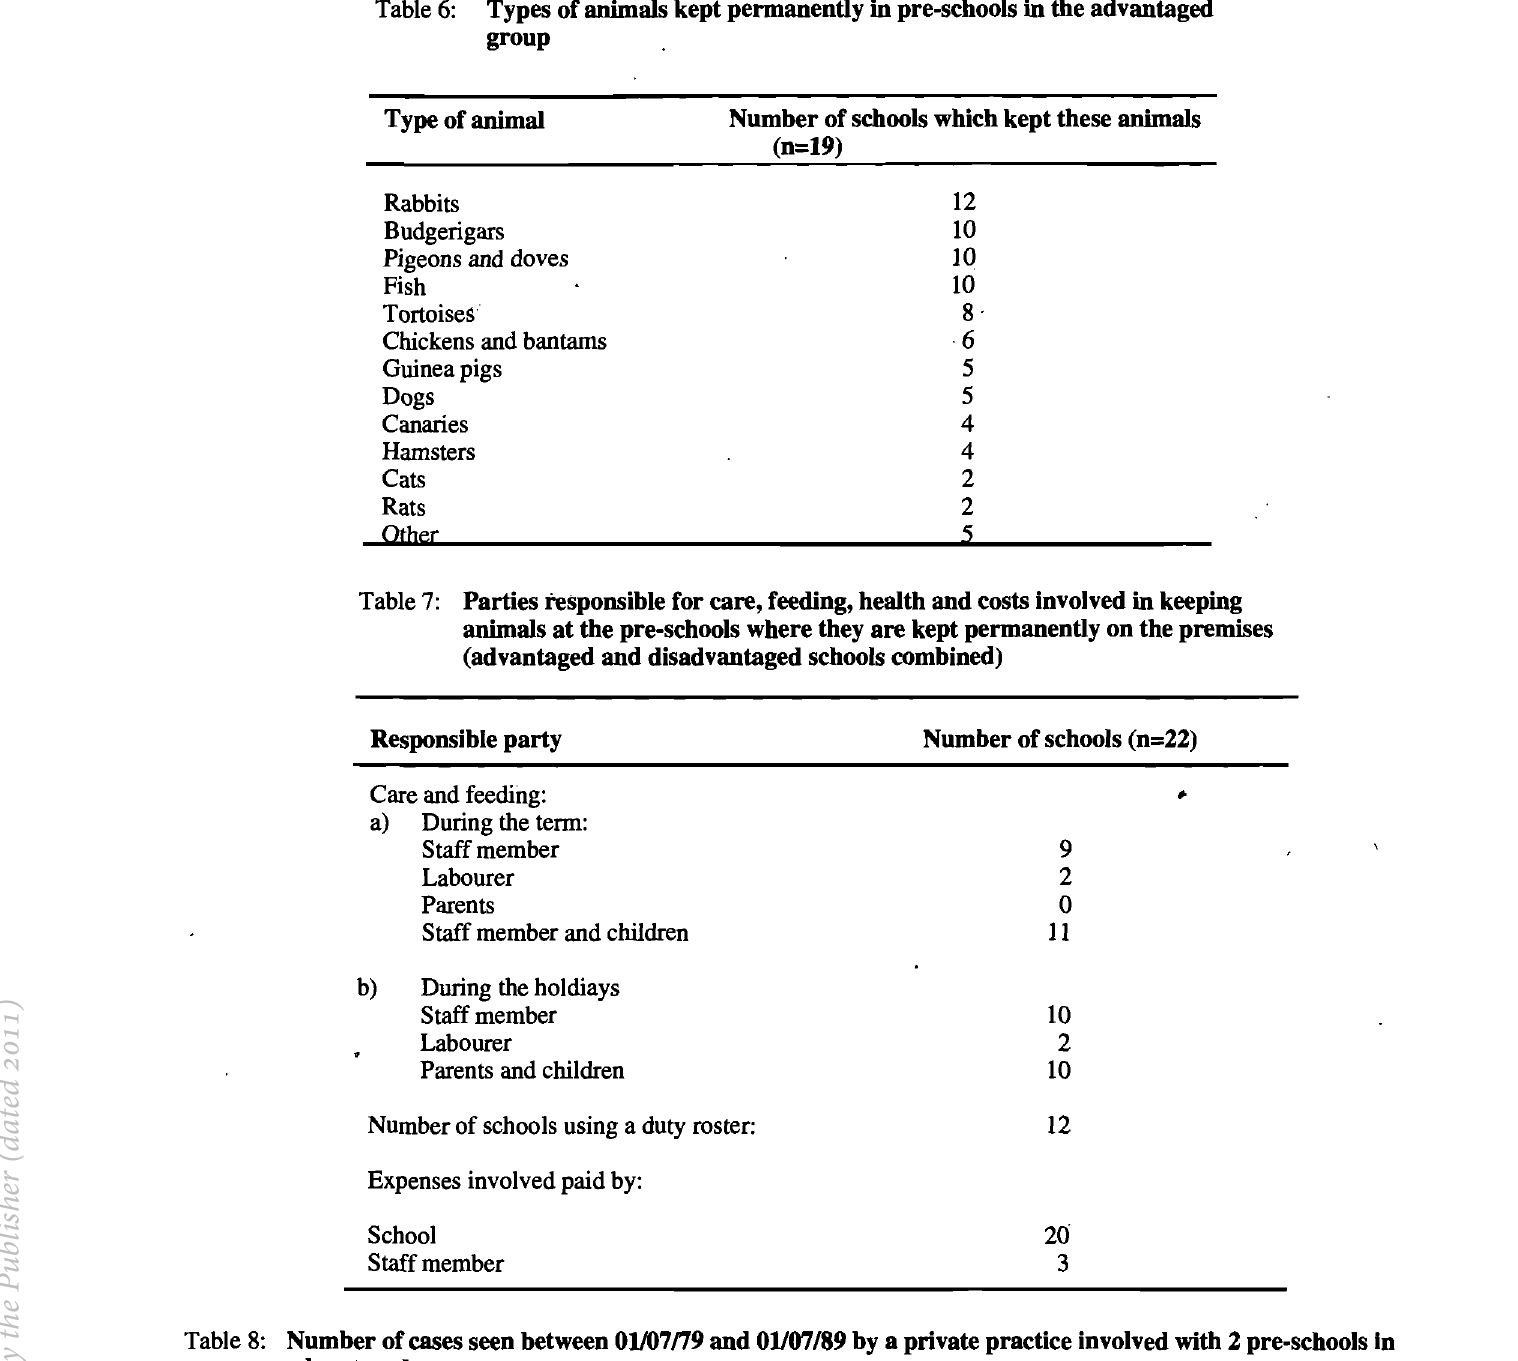
Table 8: Number of cases seen between 01/07n9 and 01107/89 by a private practice involved with 2 pre-schools in advantaged